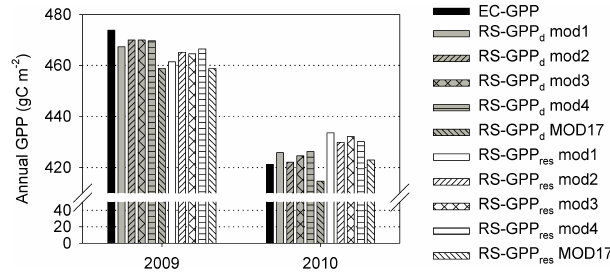
Fig. 7. Cumulated GPP d (gCm − 2 ) estimated from EC measure- ments, modelled with daily measured and resampled inputs in 2009 (left bars) and 2010 (right